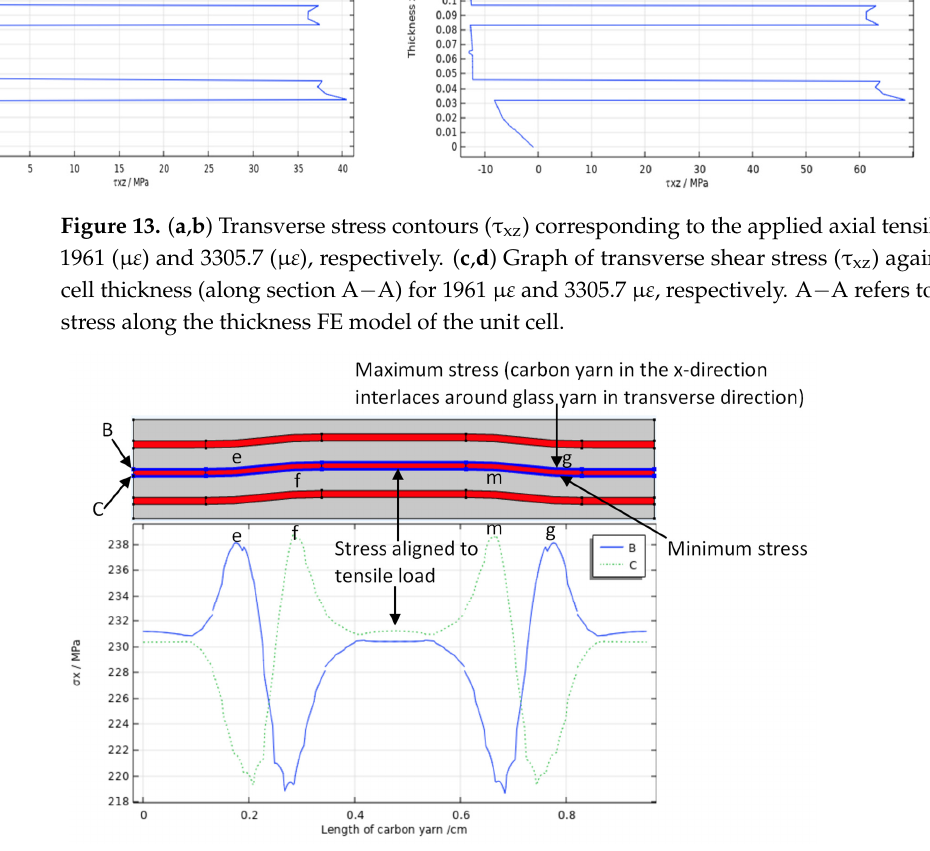
Figure 14. The distribution of axial stress ( σ x ) at the interface between the carbon yarn and the matrix for the applied tensile strain of 1961 µ ε . B and C refer to the axial stress along the length of carbon yarn for the upper and lower surface.